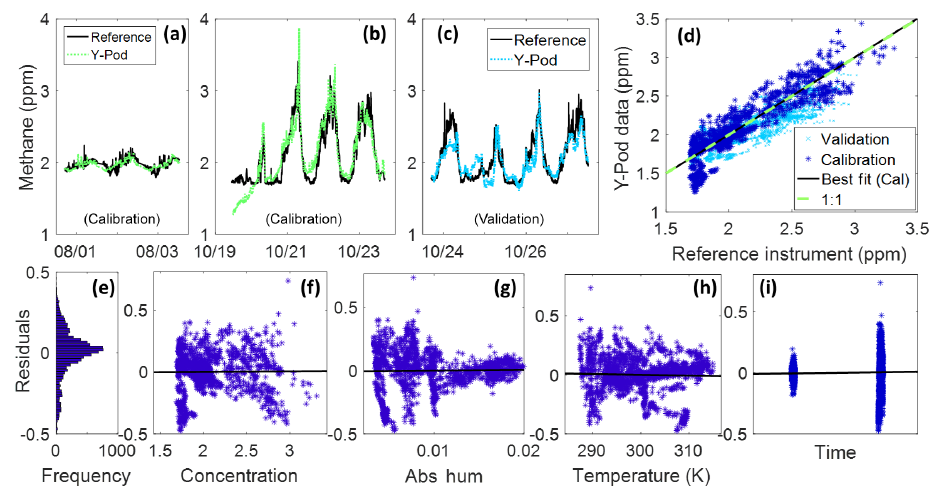
Figure 9. “Best-fitting” model (Mdl5_2Int_Tr) for the Los Angeles data with residual analysis (LA1 shown) (for validation data, RMSE is 0.160ppm and mean absolute percent error is 5.75%). Panels (a–c) are time series of the reference data and converted sensor data. Panel (d) is a scatter plot of the same data. Panels (e–i) are the residuals from the calibration generation. Table 4. Calibration and validation results for the universal calibration method ( ∗ – normalized Y-Pod data). Calibration